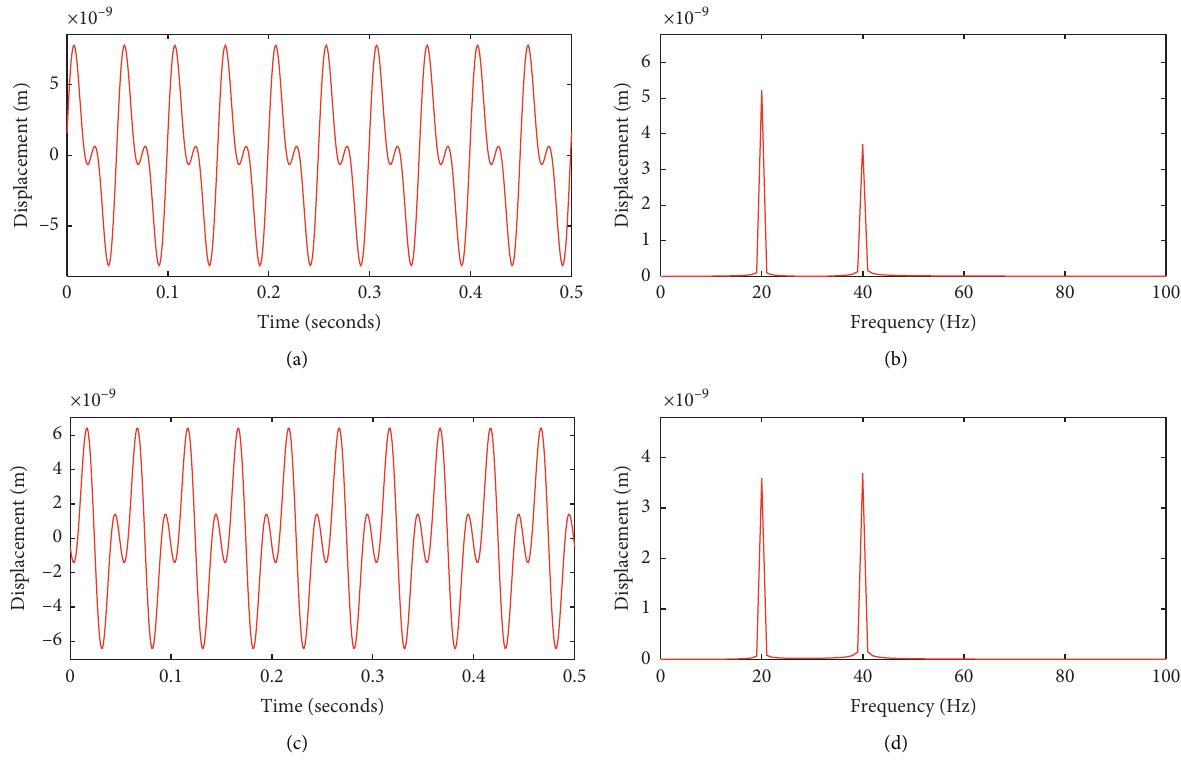
Figure 14: Time- and frequency-domain responses in the radial directions x misalignment. (a) Time response of x1. (b) Frequency response of x1. (c) Time response of x2. (d) Frequency response of x2.